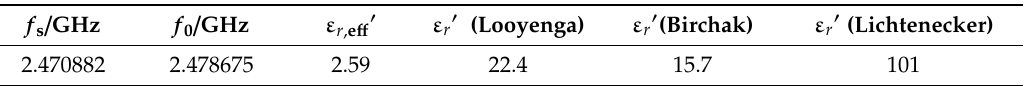
Table 3. Results of the investigation of the ceria powder sample in the simplified resonator geometry. f s /GHz